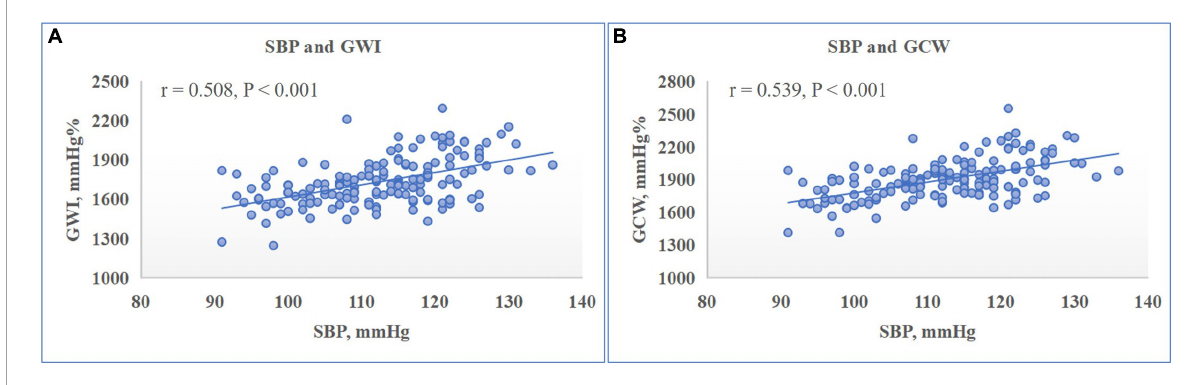
FIGURE2 Relationship between left ventricular (LV) myocardial work indices and systolic blood pressure (SBP). Scatter plot presented the significantly positive correlation between LV global work index (GWI) (A) and global constructive work (GCW) (B) with